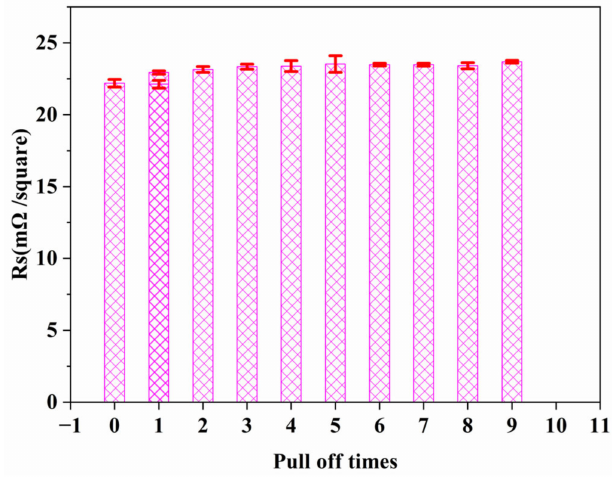
Figure 12. R s of conductive pattern after different times peeling off